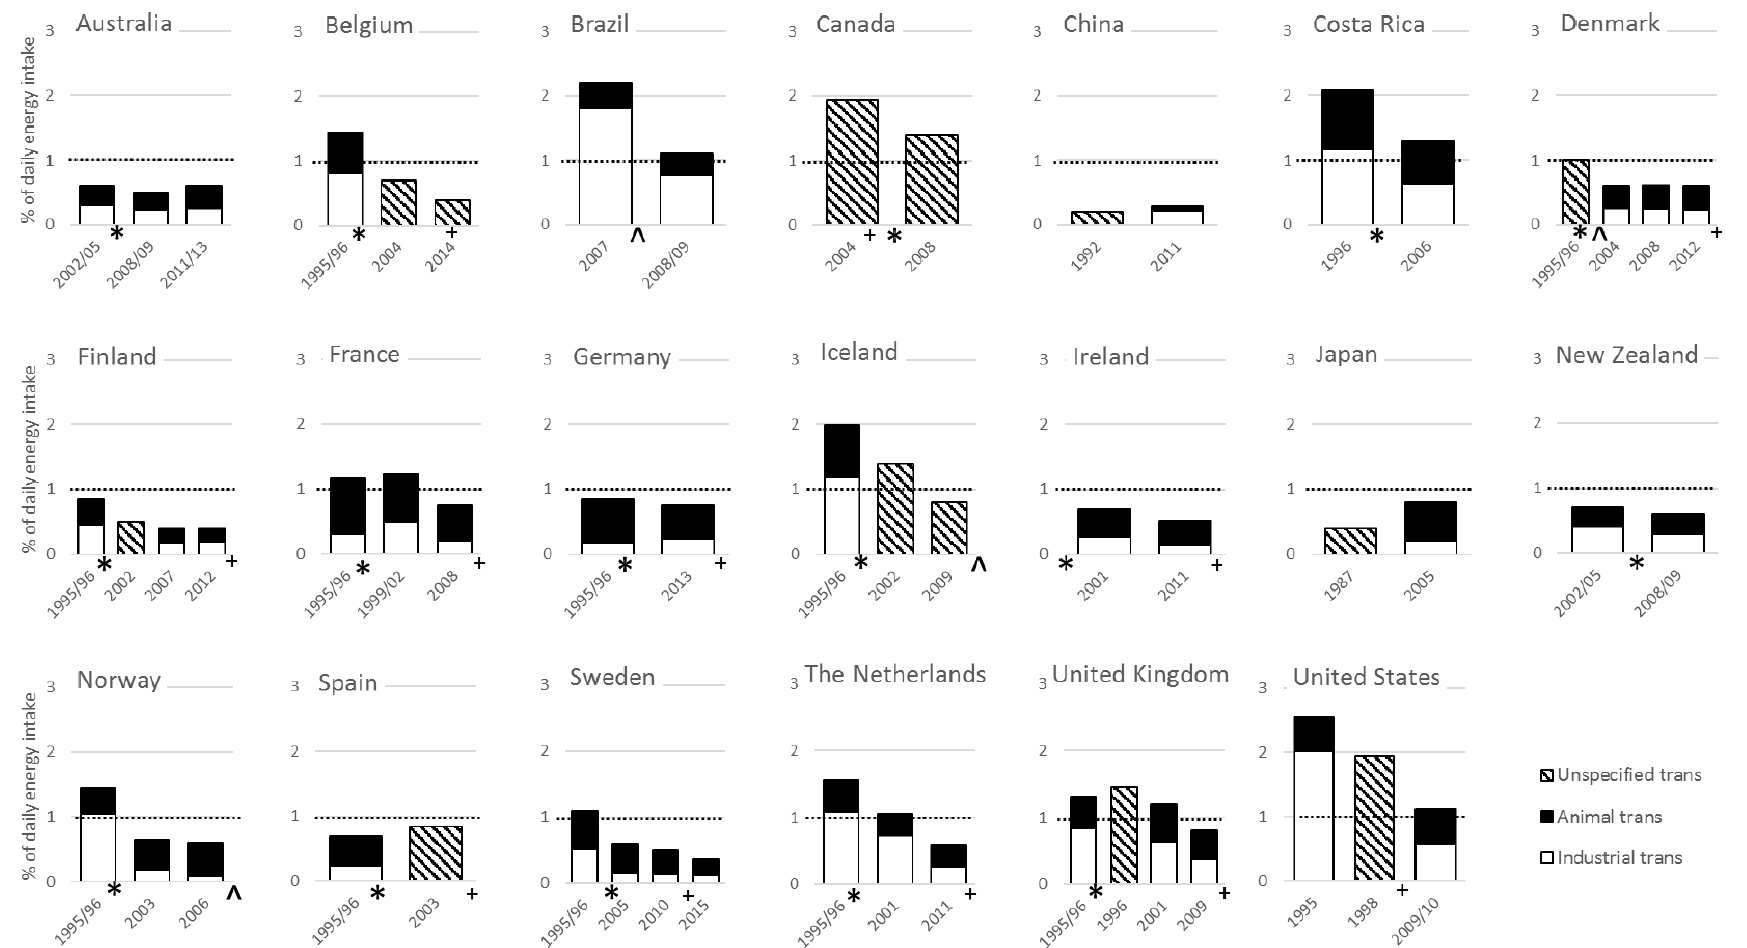
Figure 2. Time trends of intakes of trans fat and its sources in populations from 20 countries. Data reported by year of food composition data. Symbols on the time-axis refer to the year of the introduction of voluntary reductions (*), mandatory labeling ( + ), or mandatory limits (^) to lower trans fat intake. The dotted lines represent the maximal recommended intake level of trans fat [6].